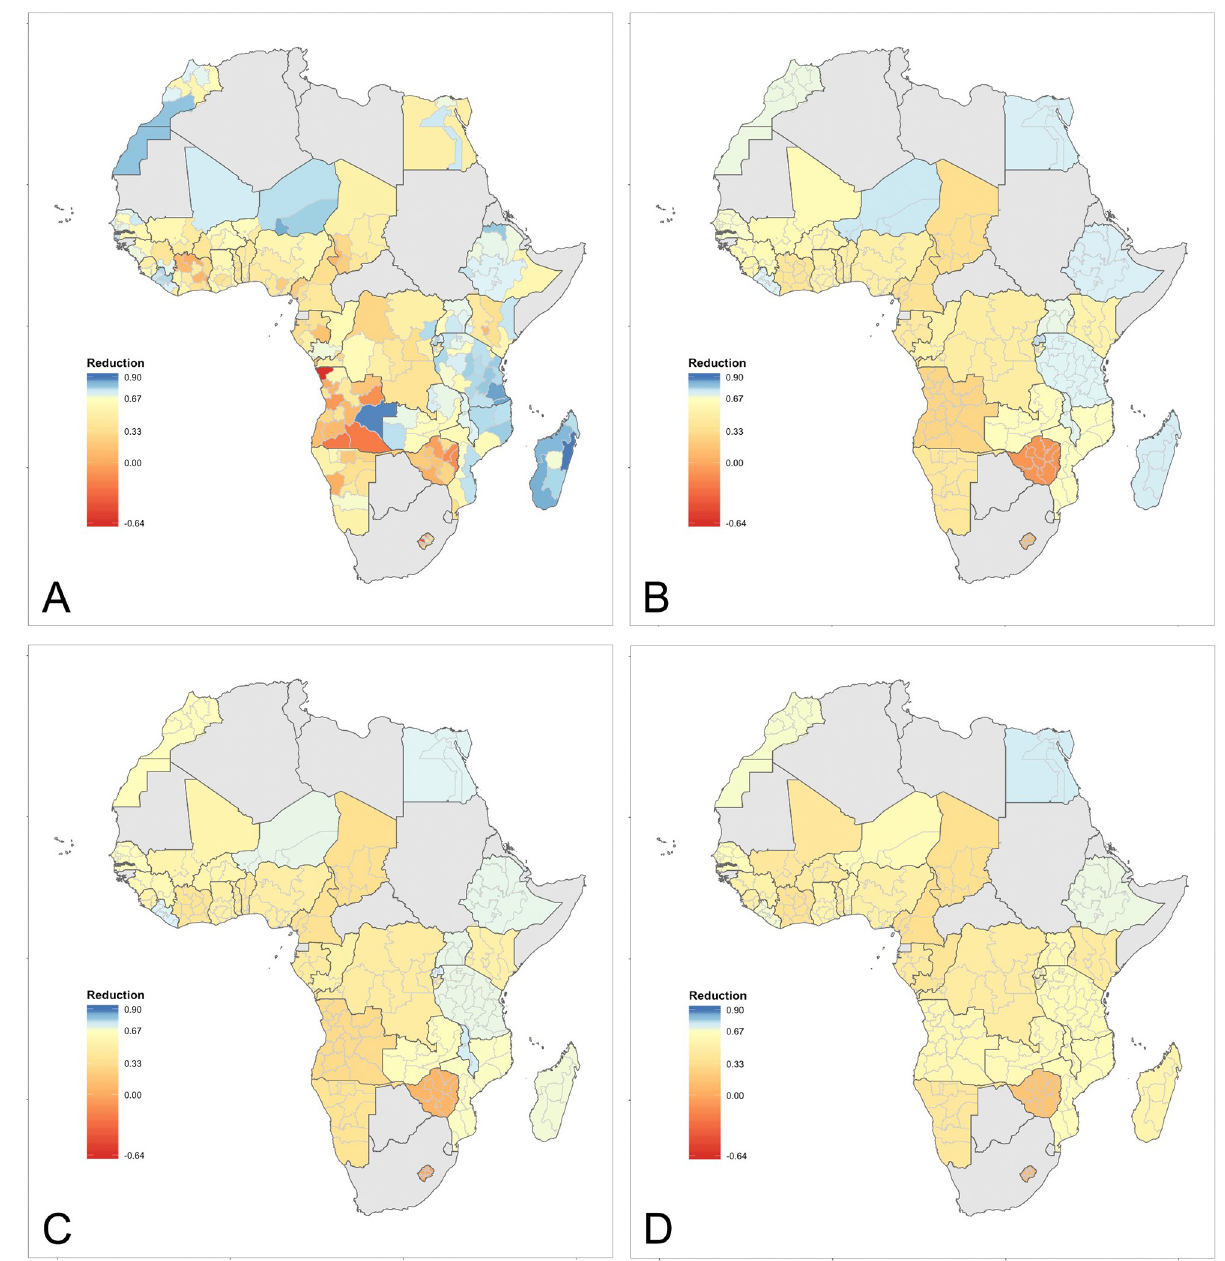
Table 1. The supporting information file S1 File contains maps of regional reductions in U5MR through time for each